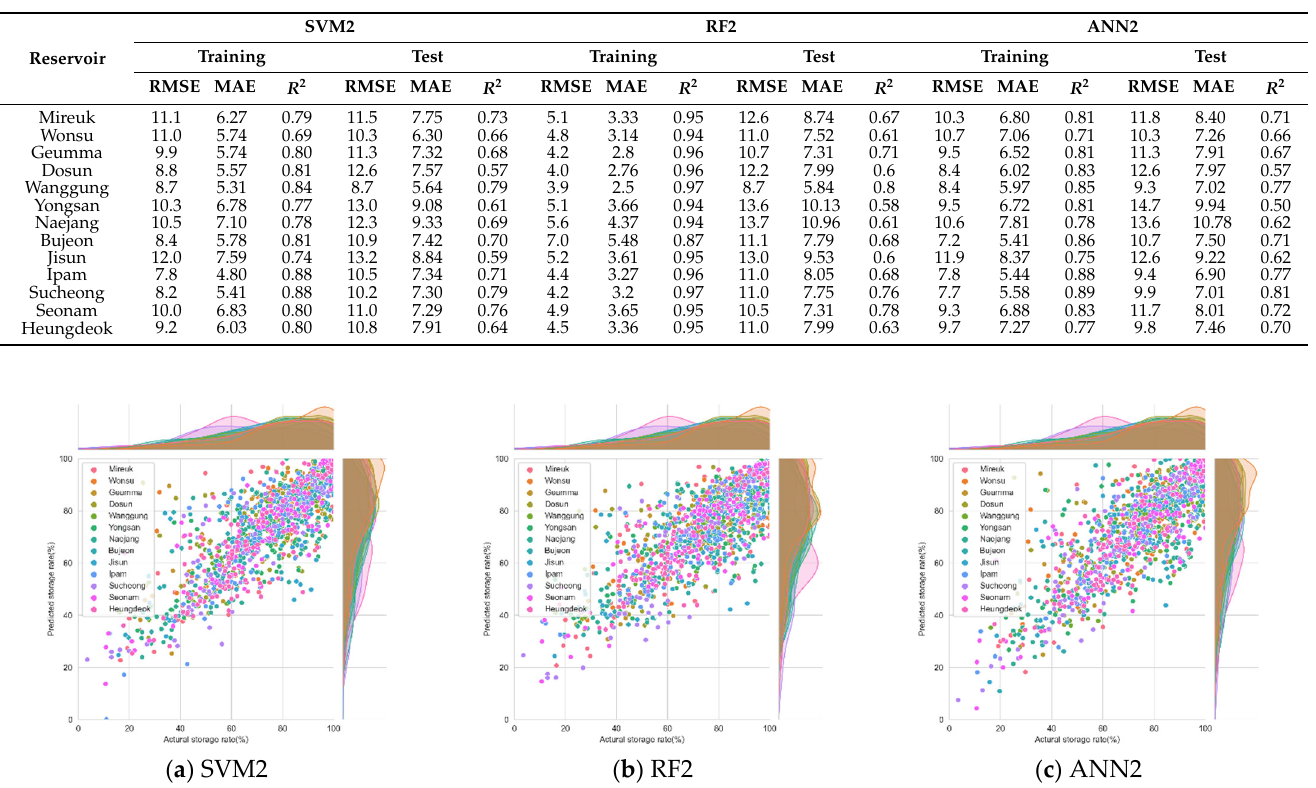
Table 7. Performance of applied models in the training and test phases for two-month forecasting.